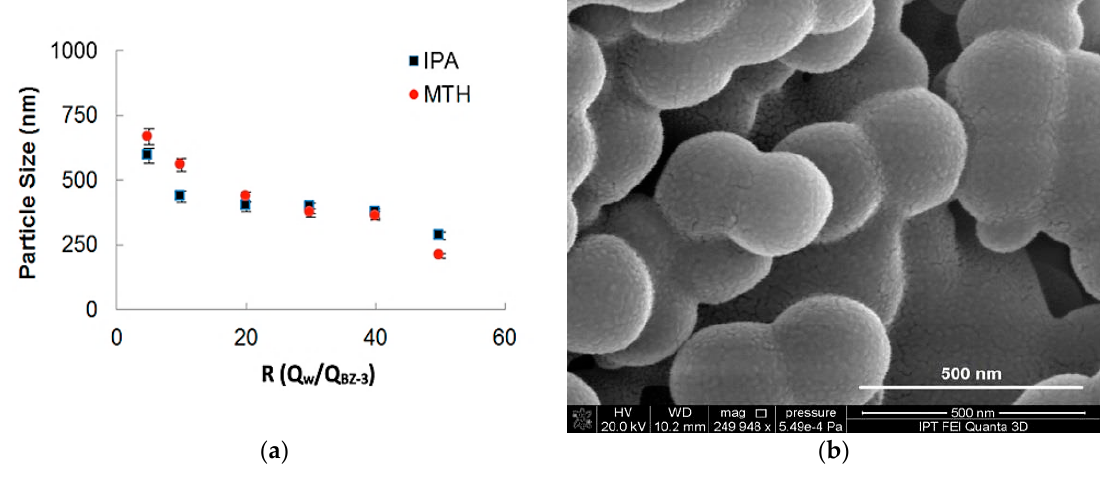
Figure 6. ( a ) Benzophenone-3 particle size as a function of the ratio between phases for two different solvents (isopropyl alcohol and methanol), ( b ) SEM-FEG micrograph obtained with a flow rate of 500 μ L/min and BZ-3 concentration of 7.5 mg/mL, yielding mean particle size of 250 nm.